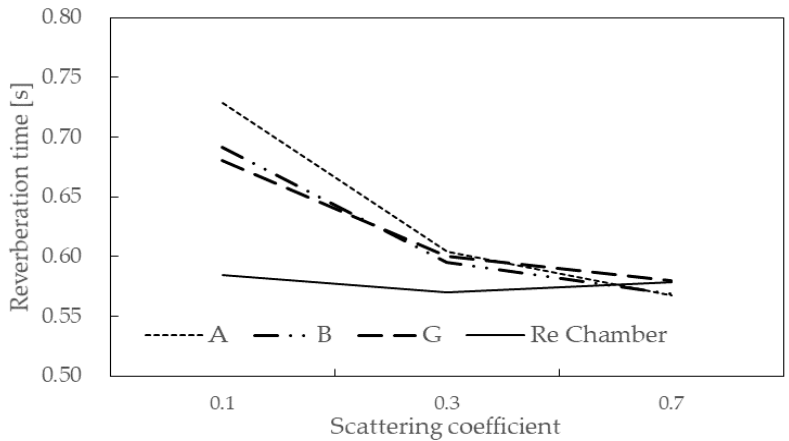
Figure 6. Variations in T 20 with a scattering coefficient in different spaces Note: A—rectangular space, B—single sidewall tilted, G—single sidewall and ceiling tilted, Re Chamber—reverberation chamber.